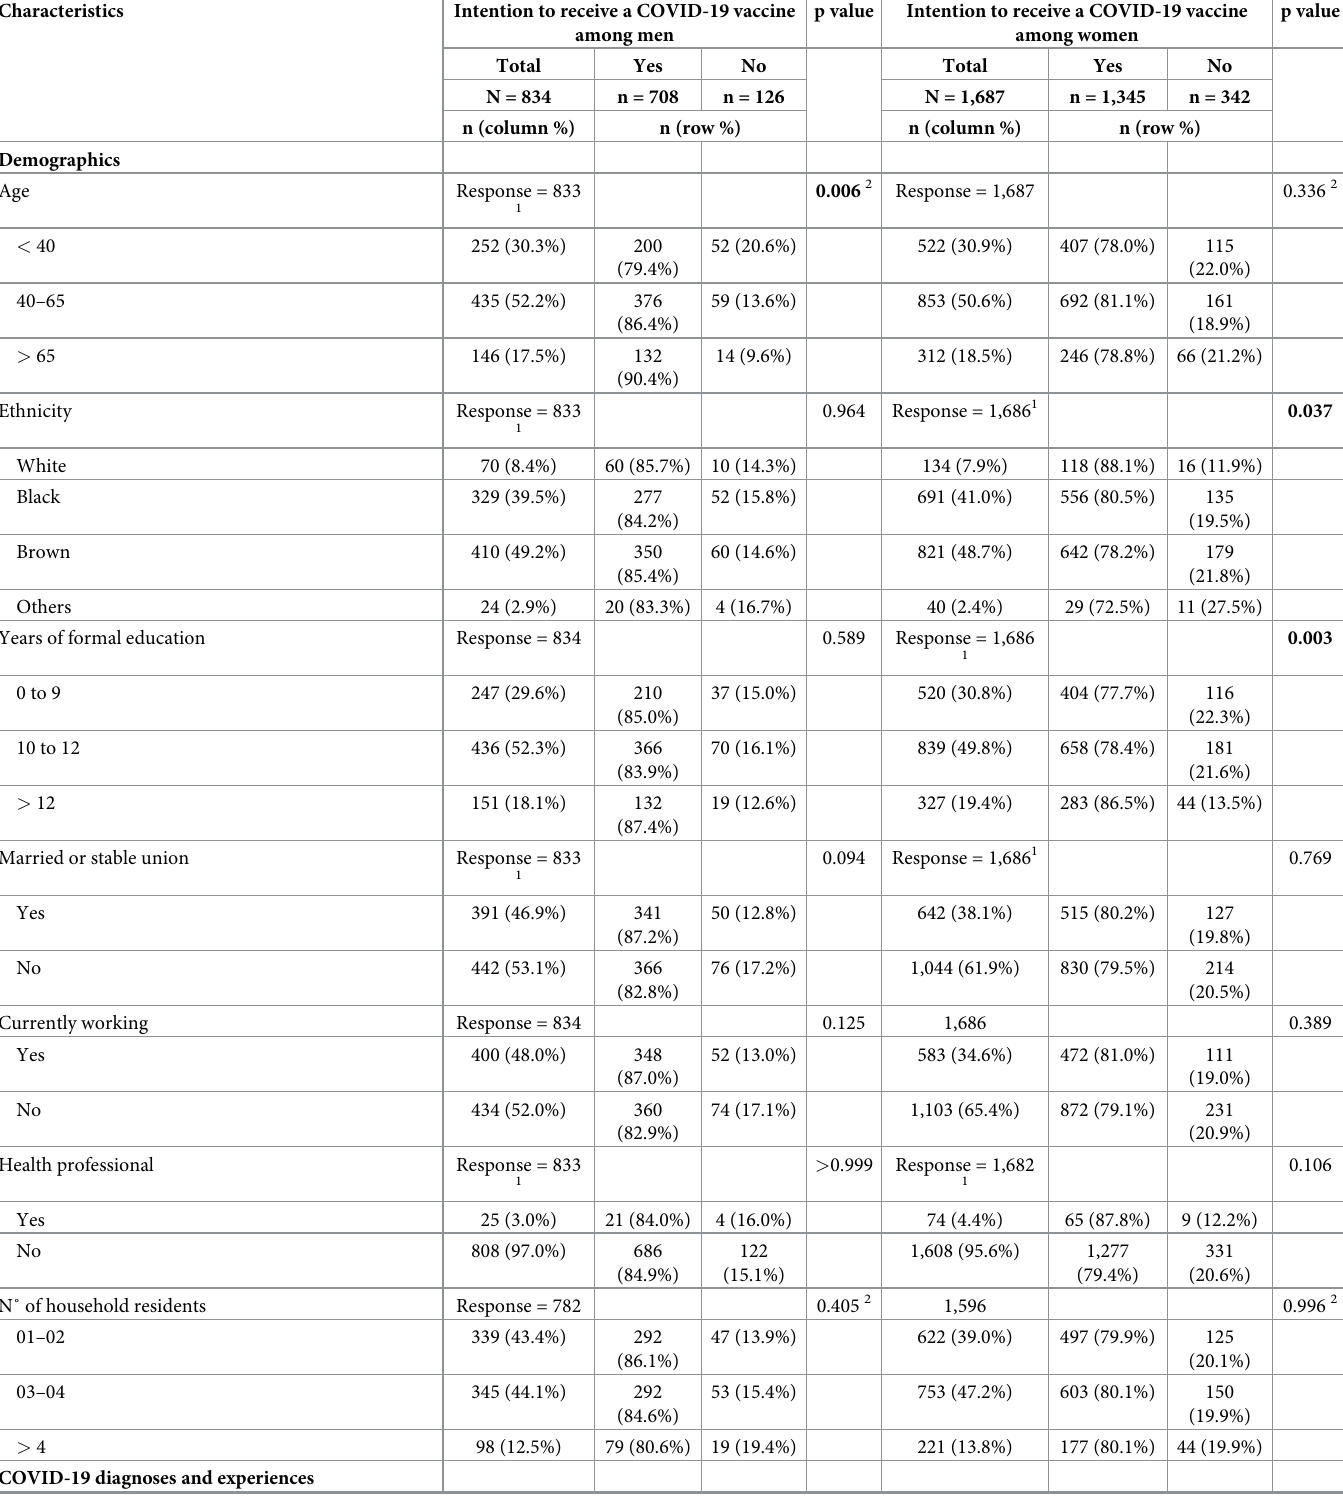
Table 1. Participants’ characteristics and intention to receive a COVID-19 vaccine among men and among women, Salvador, Brazil.